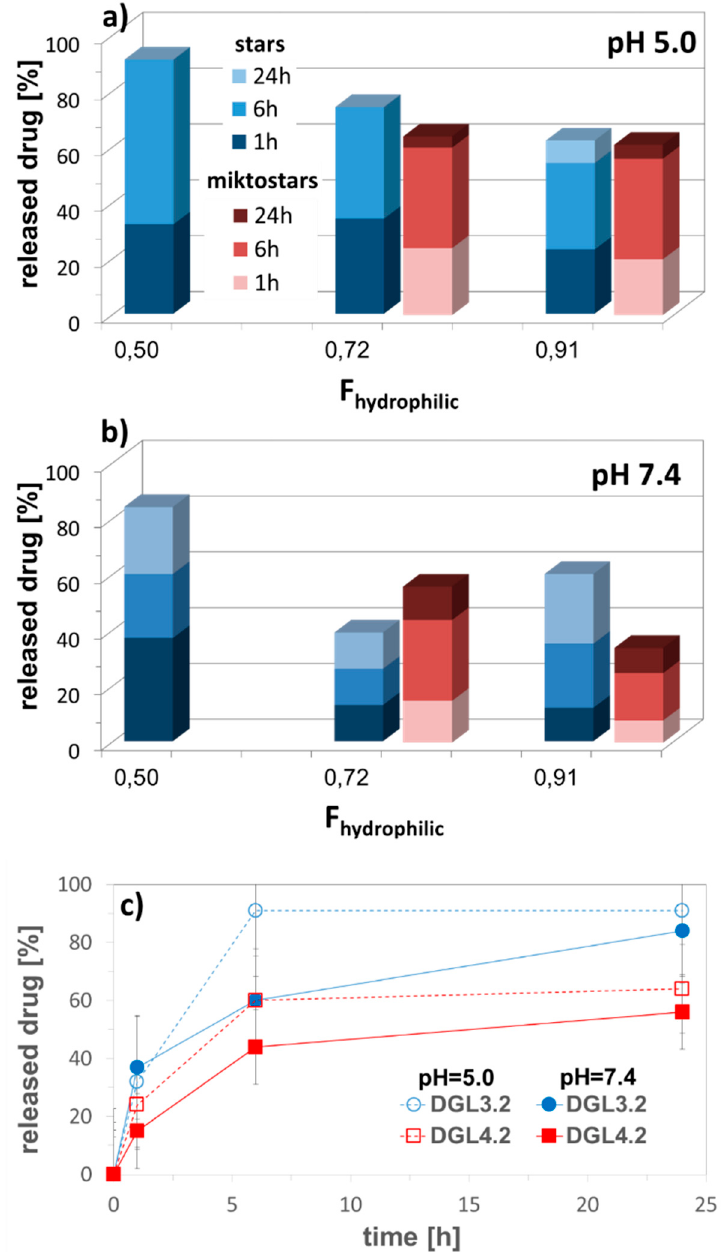
Figure 7. Amount of released DOX from self-assembled star DGL3 vs. miktostar DGL4 copolymers in correlation with content of hydrophilic fraction in acidic and neutral conditions ( a , b ), and representative release profiles of encapsulated DOX ( c ) in PBS at 37 °C.